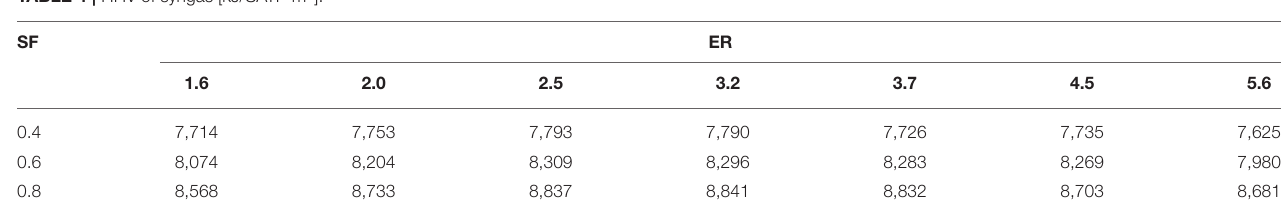
TABLE 4 | HHV of syngas [kJ/SATP m 3